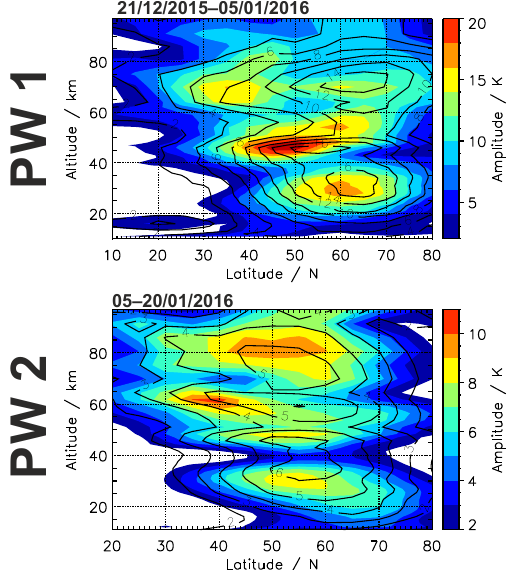
Figure 6. Altitude–latitude cross section of the amplitude of the SPW1 and SPW2 derived from MLS geopotential height data. The plot shows the average amplitude of the SPW1 and SPW2 during the period of summer-like conditions as colored contours. The black contours show the mean activity of the SPW1 using the MLS data between 2005 and